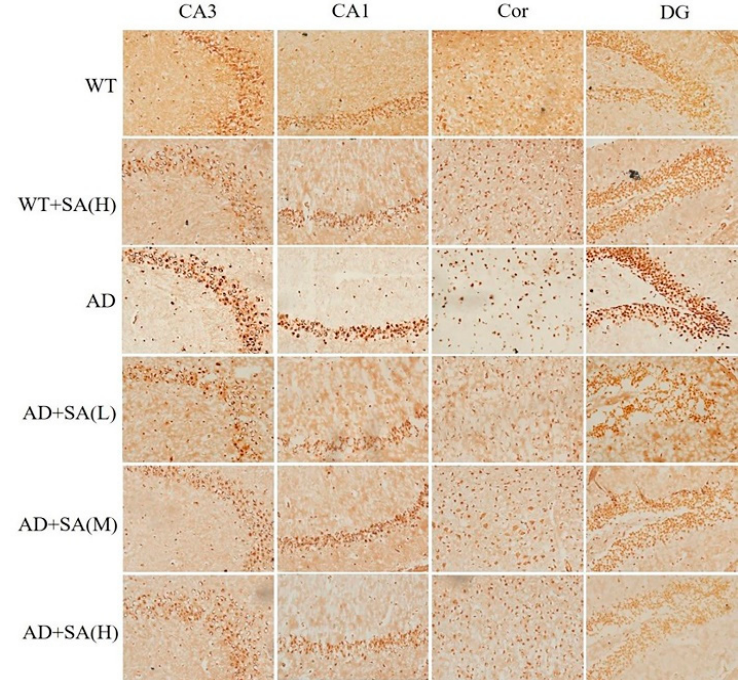
Figure 4. Effect of SA treatment on neurofibrillary tangles in the hippocampus and cortex of 2 × Tg AD mice (20 × ) ( n = 4; scale bars = 25 µ